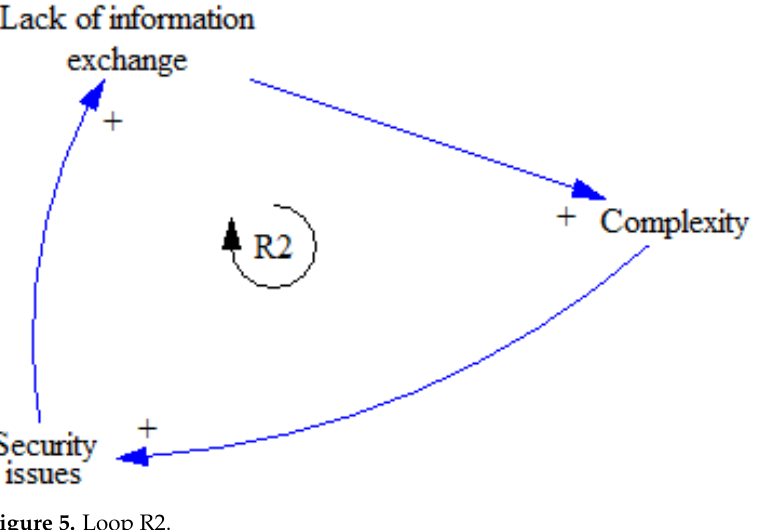
Figure 5. Loop Figure 5. Loop R2.